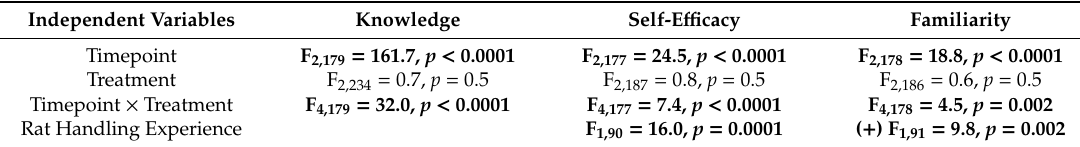
Table 3. Knowledge, self-e ffi cacy, and familiarity with rat tickling. The associations from general linear mixed models of self-reported data from laboratory animal personnel. Participants were asked about their factual knowledge, self-e ffi cacy, and familiarity with rat